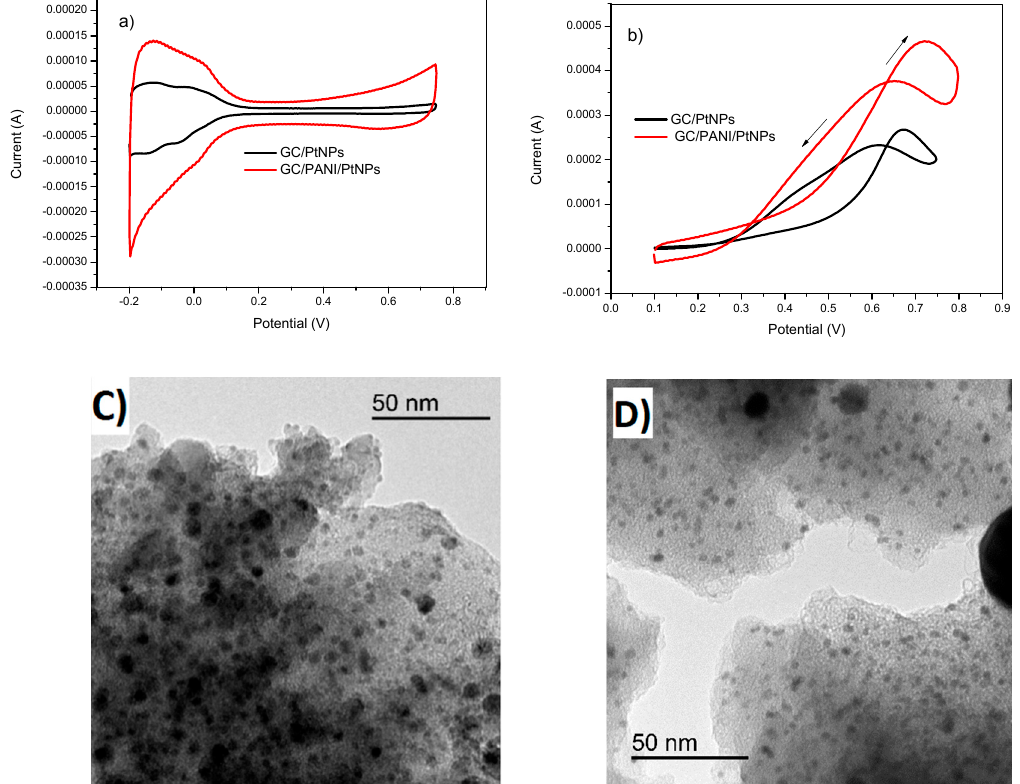
Figure 2. ( a ) Cyclic voltammetry in 0.5M H 2 SO 4 and ( b ) in in 2 M methanol of glassy carbon (GC)/polyaniline (PANI) (CV)/PtNPs (red) and GC/PtNPs electrodes (black) obtained by potentiostatic pulsed electrodeposition method. The corresponding TEM images of GC/PANI(CV)/PtNPs electrodes. Deposition conditions: ( c ) E on = − 1 V, ( d ) E on = − 750 mV. E off = +1 V, t on =10 ms, DC= 50%, t dep =100 s, K 2 PtCl 6 = 5 mM.